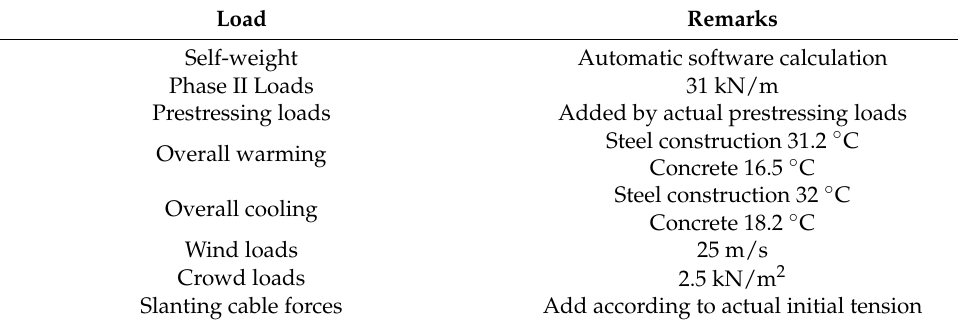
Table 3. The bridge sub-load table.